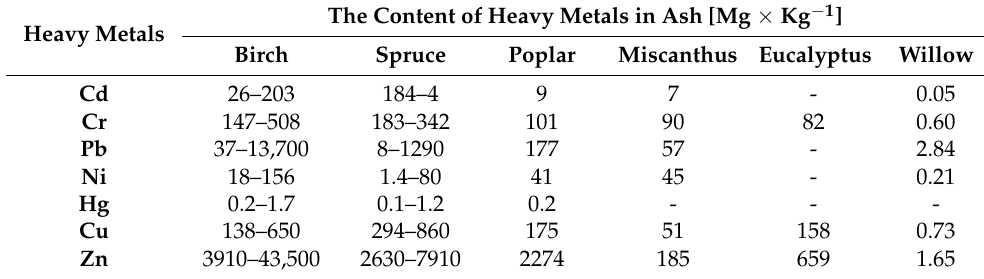
Table 2. Heavy metals concentration in fly ash on the example of spruce and birch wood. Heavy